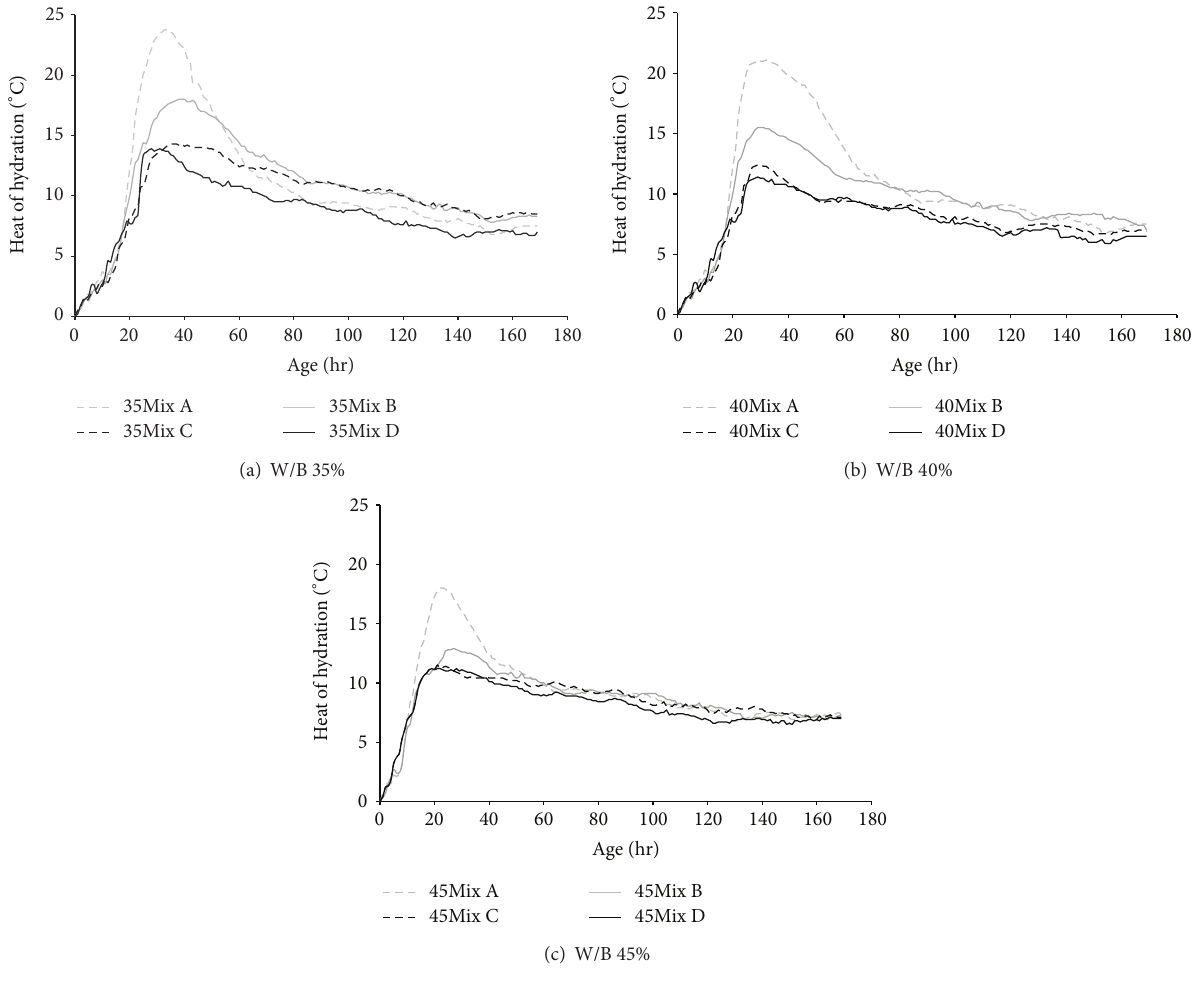
Figure 9: Hydration heat of